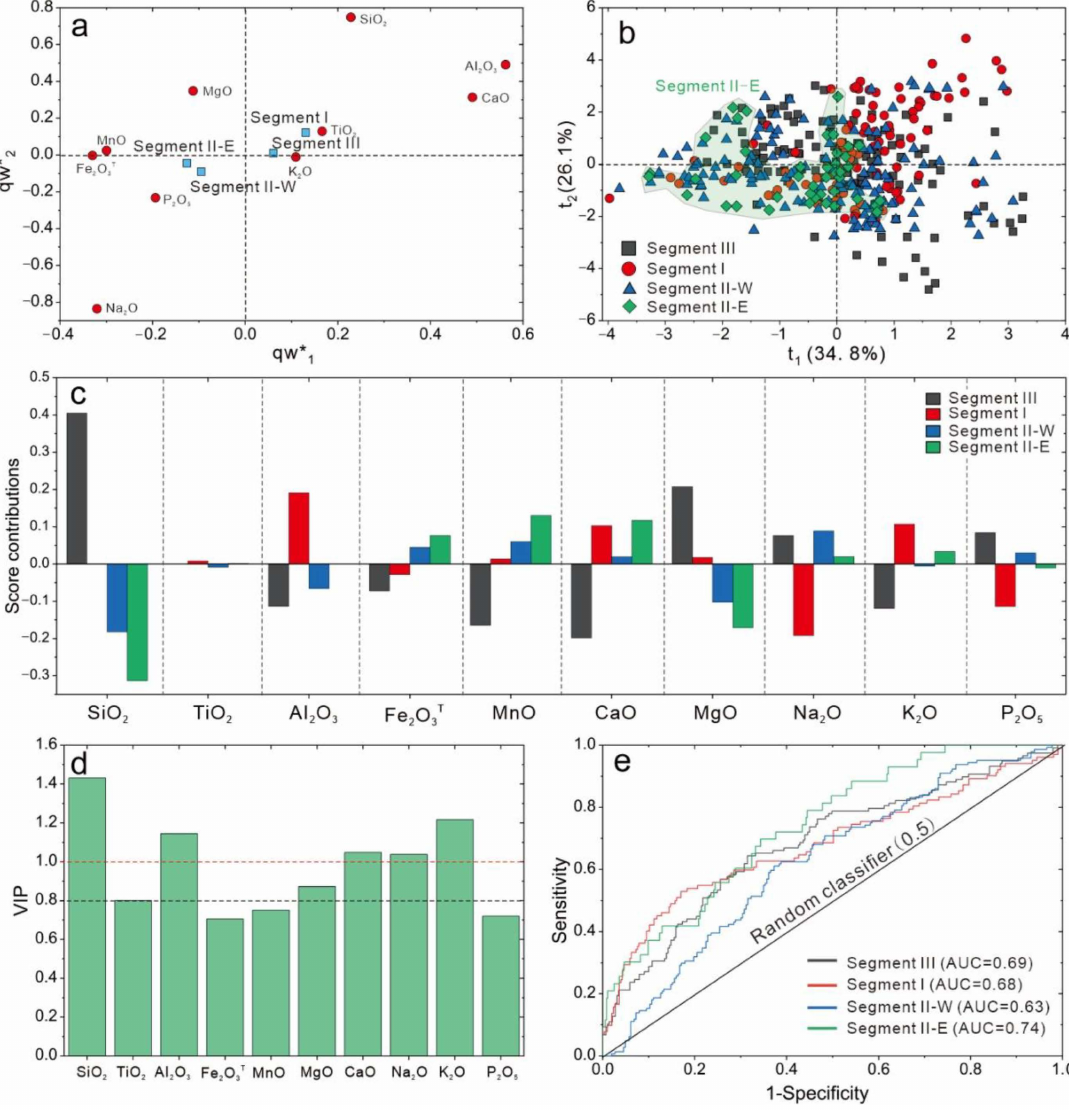
Figure 8. Partial least squares-discriminant analysis (PLS-DA) of whole-rock major element data in each segment from the Jinchuan deposit. ( a ) The qw* 1 –qw* 2 (first and second loadings) plots show the correlation between elemental variables and the relationship between different elements and classification subgroups; loadings values indicate the influence of elements on classification, and the sign of the value indicates a positive or negative correlation between elements; and elements plotted at the far end of the loadings plot contribute most to the classification of subgroups in the score plot, while near the origin elements plotted near the origin have a negligible effect on the classification. ( b ) The t 1 –t 2 (first and second scores) plot illustrate the sample distribution controlled by the correlation between samples in the loadings plot, with the green polygon circling the main areas of Segment II-E. ( c ) Score contributions plot, used to assess the association between predictor and response variables. ( d ) The variable importance on the projection (VIP) values reflects the significance of compositional variables for the classification of samples in the score plot (t 1 –t 2 ), with the red dashed line in the VIP plot indicating a threshold of 1 and the black dashed line indicating a threshold of 0.8. ( e ) ROC curve for evaluating model effect. Data sources as in Figure